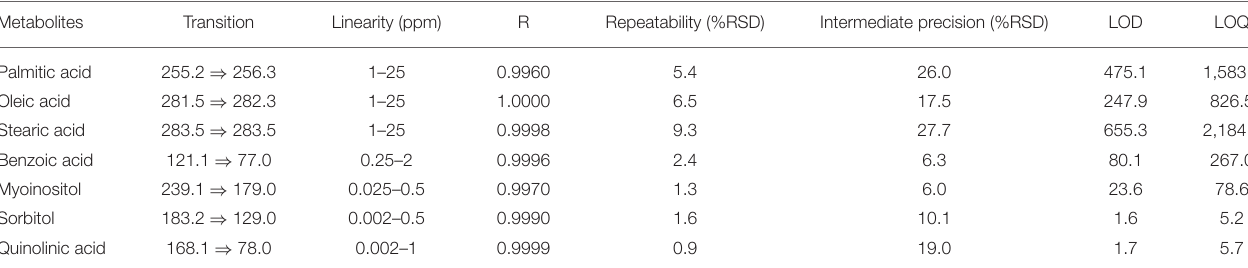
TABLE 5 | The analytical parameters of significantly different metabolites between PD cases and control subjects. Metabolites Transition Linearity (ppm) R Repeatability (%RSD) Intermediate precision (%RSD) LOD LOQ Palmitic acid 255.2 ⇒